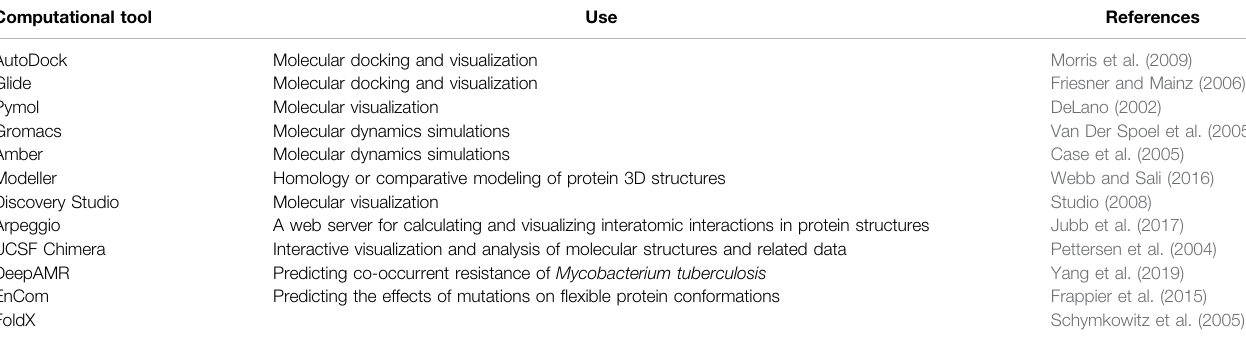
TABLE 2 | Computational tools used in the study of mutations.